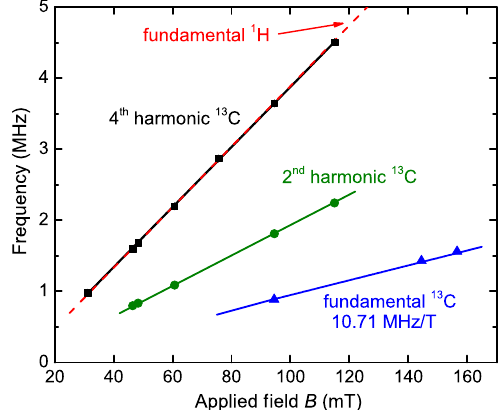
ns.FIG. 6. Frequency of peak response for various magnetic bias fields B , measured using an XY 8 sequence. Points are measured peak positions. Solid lines have slopes chosen to be 1, 2, and 4 times the gyromagnetic ratio of 13 C. The red dashed line has a slope given by the gyromagnetic ratio of 1 H and is almost identical to the 13 C fourth harmonic line (black